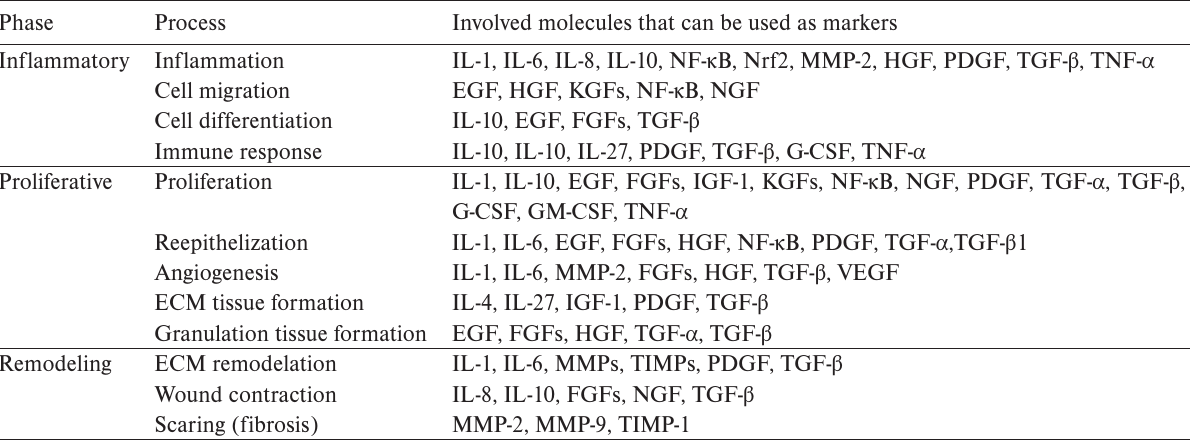
Table 2. Markers for particular phases and processes in wound healing 12-14,17,155 .